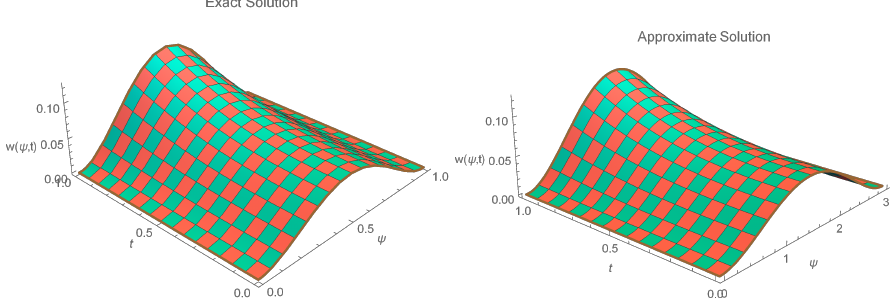
Figure 9. Three-dimensional exact and approximate solutions graphs of Example 2 obtained by the proposed scheme for γ = 0.001, ˜ M = K =